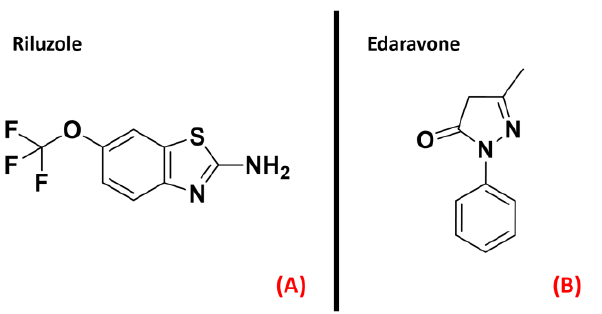
Figure 1. The chemical structures of Riluzole ( A ) and Edaravone ( B ),which are the only two small- molecule drugs approved currentlyfor ALS treatment.